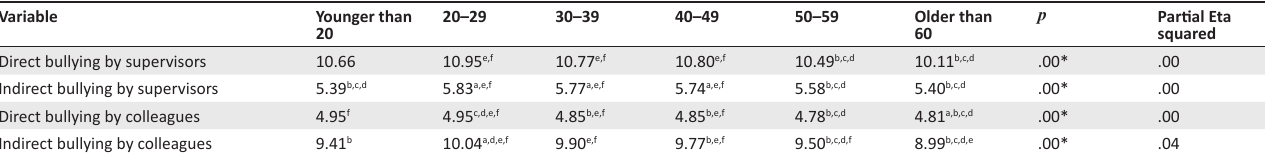
TABLE 7: Analysis of variance – differences in workplace bullying based on age.